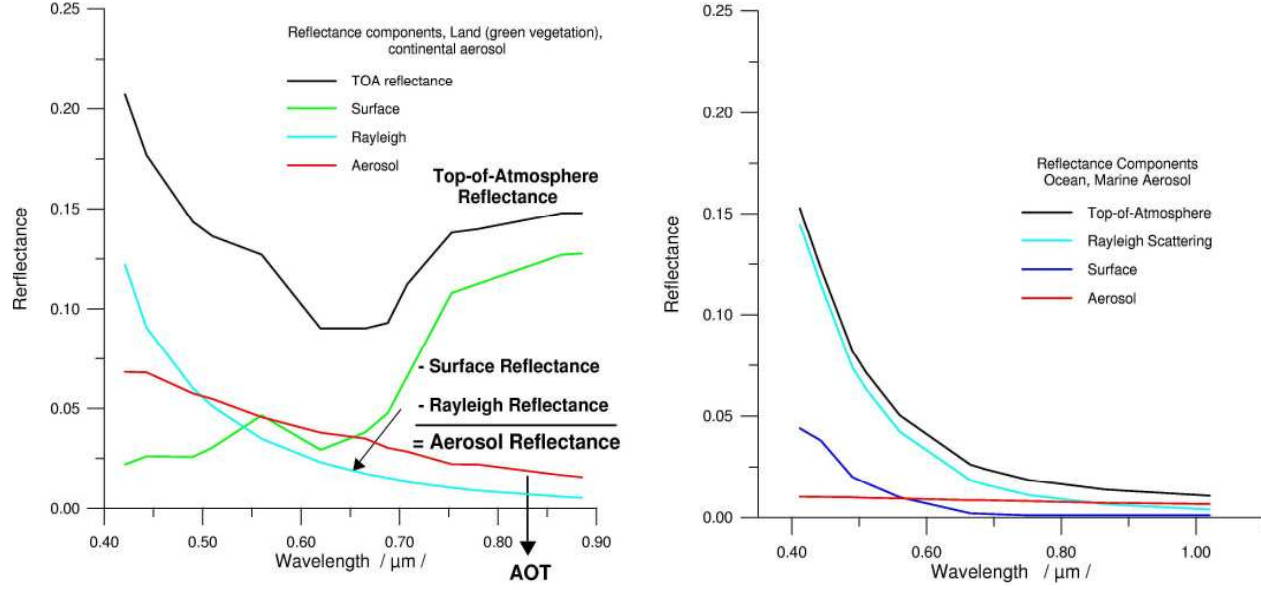
Fig. 1. Main spectral properties of land and ocean surface and its TOA reflectance. Left: land conditions with continental aerosol, right: ocean conditions with clean marine aerosol. Restrictions for the aerosol retrieval over land arise from increase of surface reflectance due to the “red edge” ( λ> 0 . 67µm) and an increased variability of surface reflectance by the chlorophyll peak at